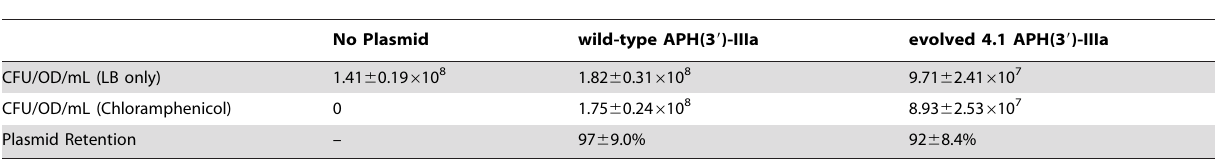
Table 6. Stability of ancestral and evolved aph(3 9 )-IIIa -pQBAV3c